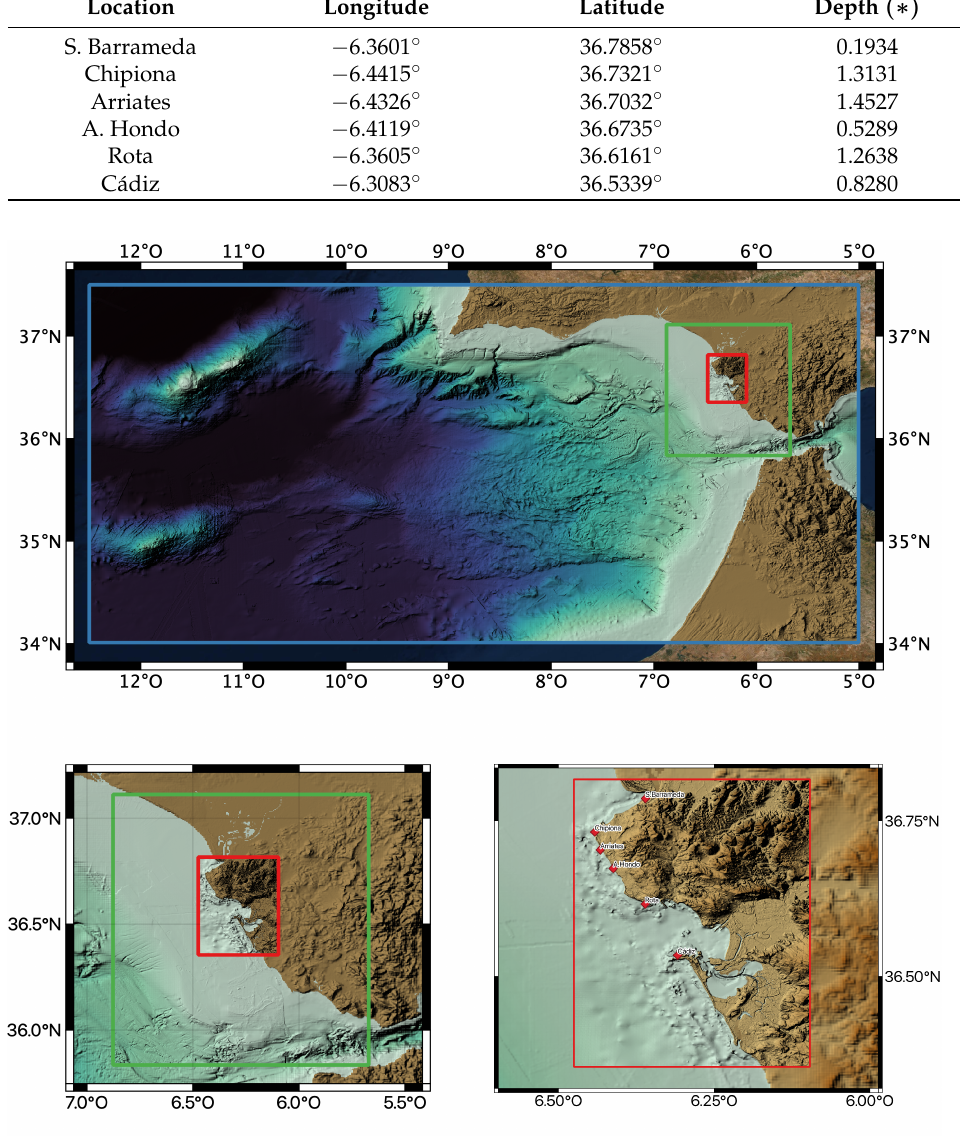
Figure 2. Bathymetry and extent of grid level 0 ( top panel ), grid level 1 ( left bottom panel ), and grid level 2 ( right bottom panel